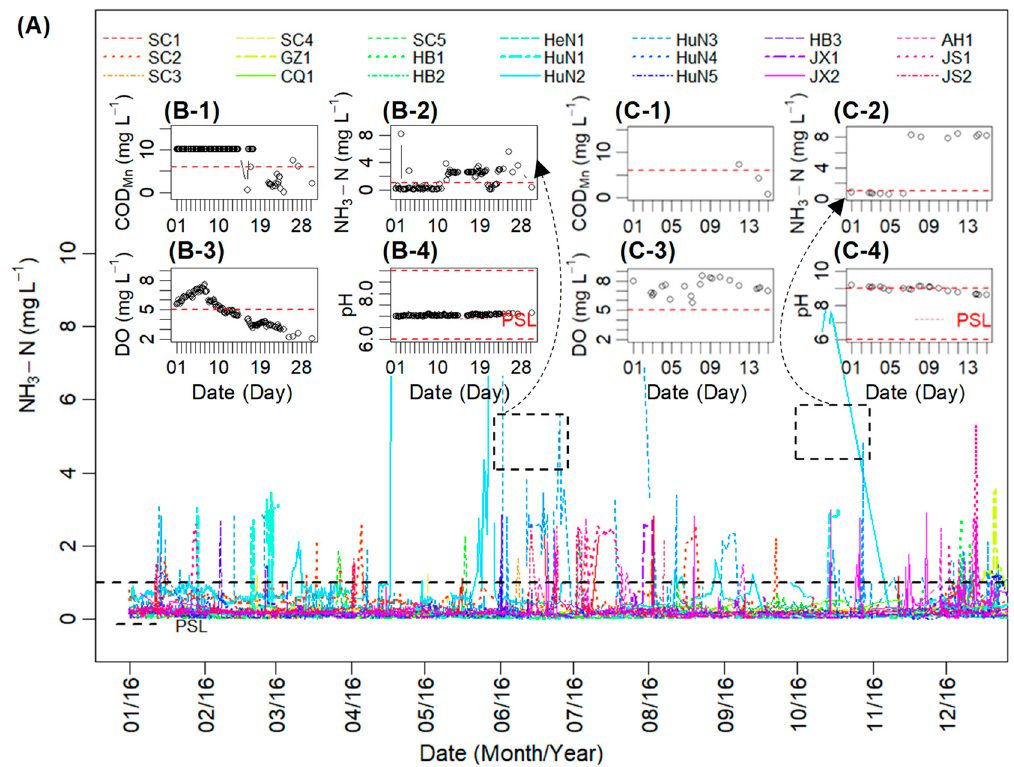
Figure 11. Real-time series for NH 3 –N ( A ) at the 21 YRB sites for 2016, and real-time series for Site HuN3 in June 2016 ( B1–4 ) and Site HuN2 in October 2016 ( C1–4